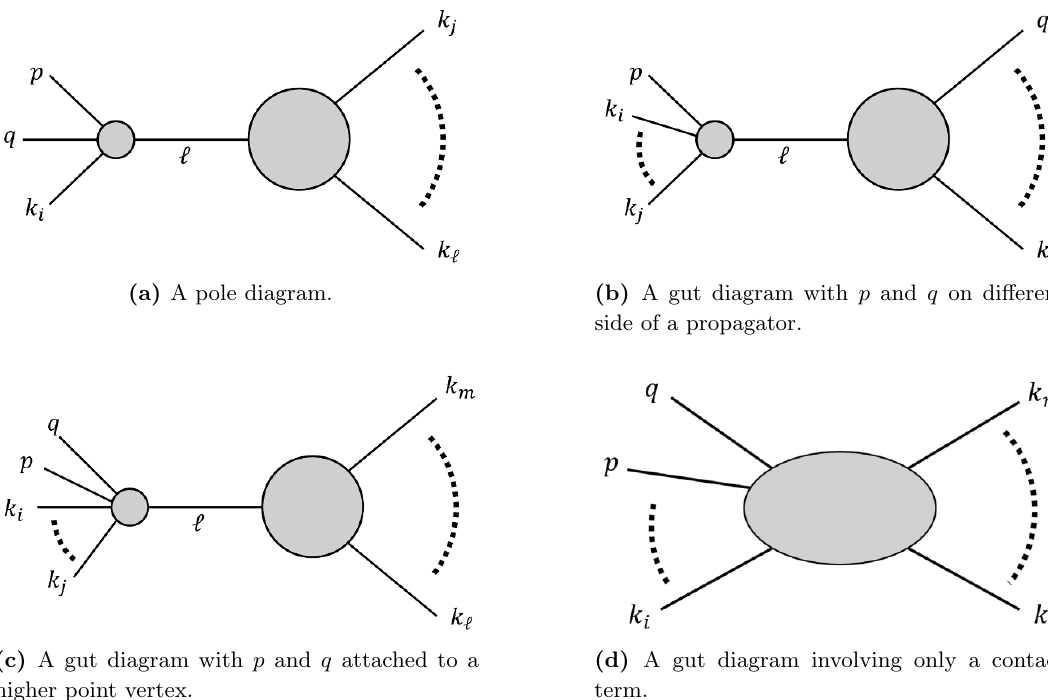
Figure 6. Pole diagrams and gut